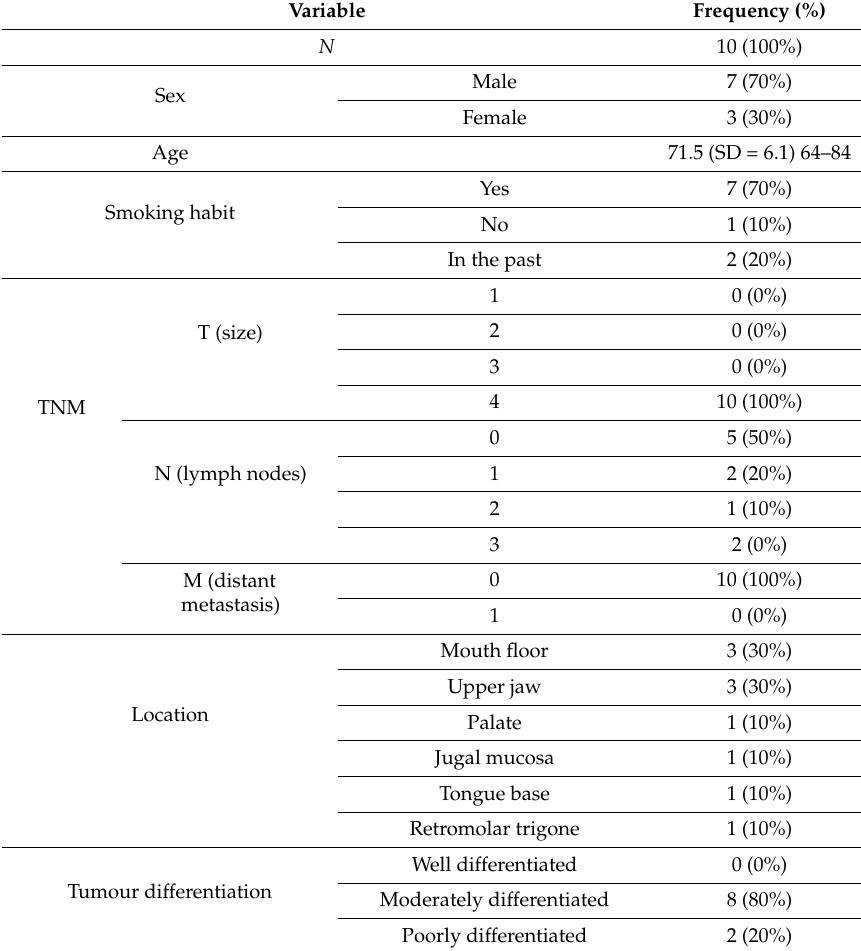
Table 1. The table reflects the frequency of the clinical-pathological variables collected from oral squamous cell carcinoma (OSCC)